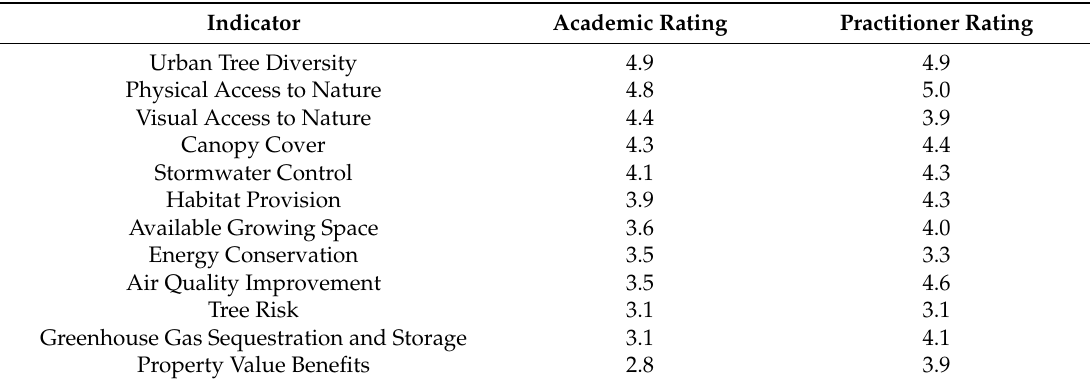
Table 2. Academic and practitioner